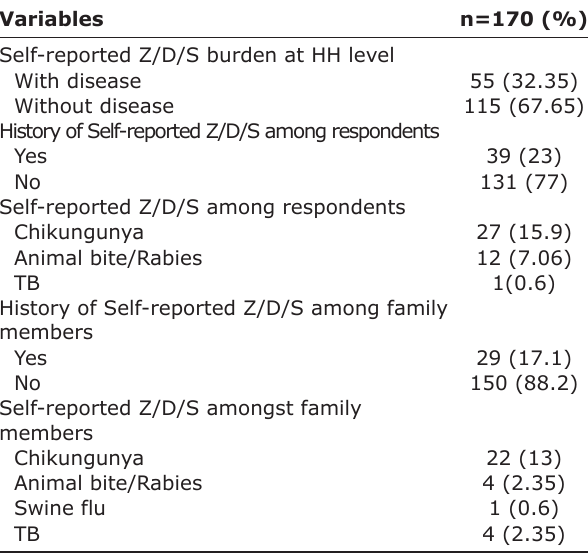
Z/D/S=Zoonotic diseases, HH=Household, TB=Tuberculosis